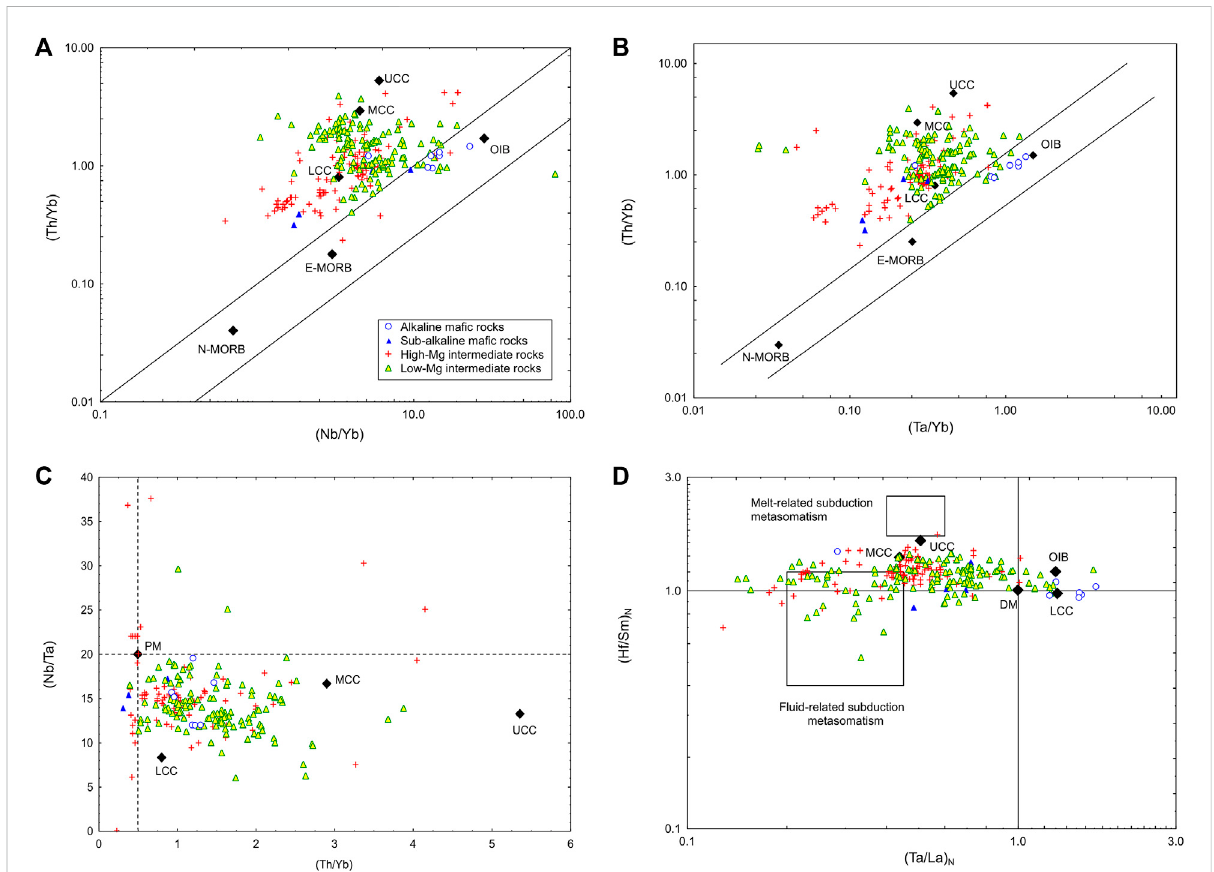
FIGURE 6 (A) (Th/Yb) vs. (Nb/Yb) diagram for the volcanic rocks from the MGVF. (B) (Ta/Yb) vs. (Nb/Yb) diagram for the volcanic rocks from the MGVF. (C) (Nb/Ta) vs. (Th/Yb) diagram for volcanic rocks from the MGVF. (D) (Hf/Sm) N vs. (Ta/La) N diagram, melt, and fl uid-related subduction metasomatism areas are from La Fléche et al. (1998). Abbreviations: OIB, ocean island basalt; E-MORB, enriched mid-ocean ridge basalt; N-MORB, normal mid- ocean ridge basalt; LCC, lower continental crust; MCC, middle continental crust; UCC, upper continental crust; PM, primitive mantle; and DM, depleted mantle. Continental crust values are taken from Rudnick and Gao (2003). Mantle values are taken from McDonough and Sun